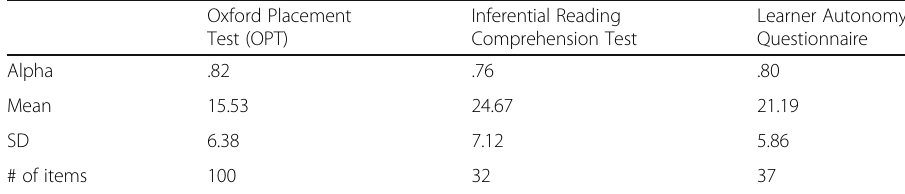
Table 1 Reliability of Iinstruments ( N = 213)